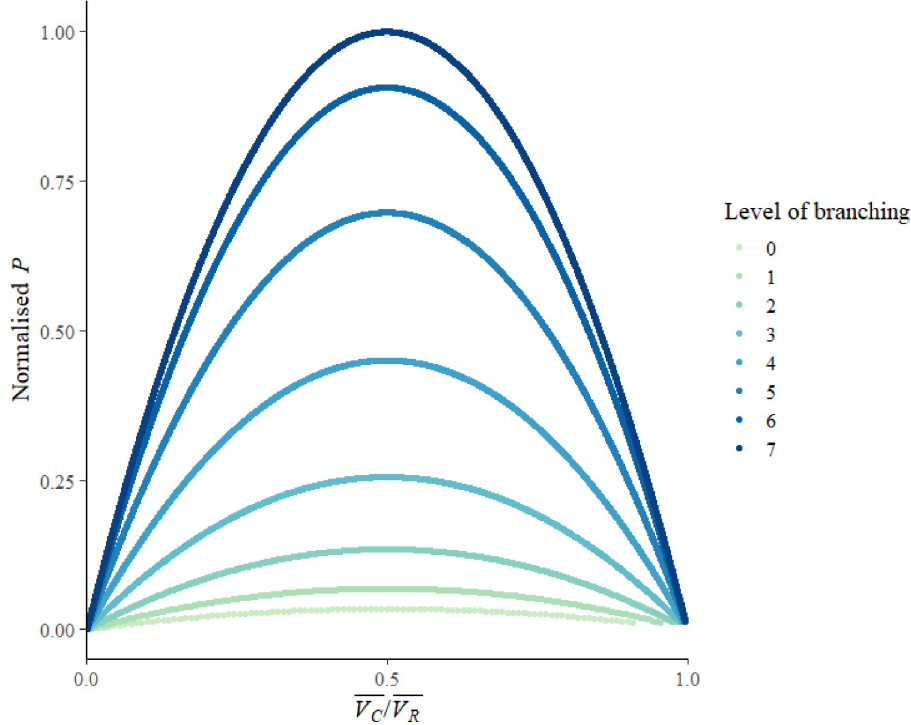
Fig 5. The total final power consumption ( P ) against the ratio of mean consumer potential to mean resource potential ( V = V ) for each level of the ‘evolved branching’ networks. With additional levels of branching, the C R network became more similar to a fractal branching structure: average link length shortened, and resource flow was concentrated onto fewer, more shared links. Here, each coloured point series represents the trajectory of final power consumption as the network became more branched: Level 0 had no branch points, and Level 7 was a fully self-similar fractal. Relative total final power is the sum of final power consumption at all consumer nodes, normalised by the maximum power achieved by the network, which preserves relative differences. A copy of the figure with raw data is included in S2